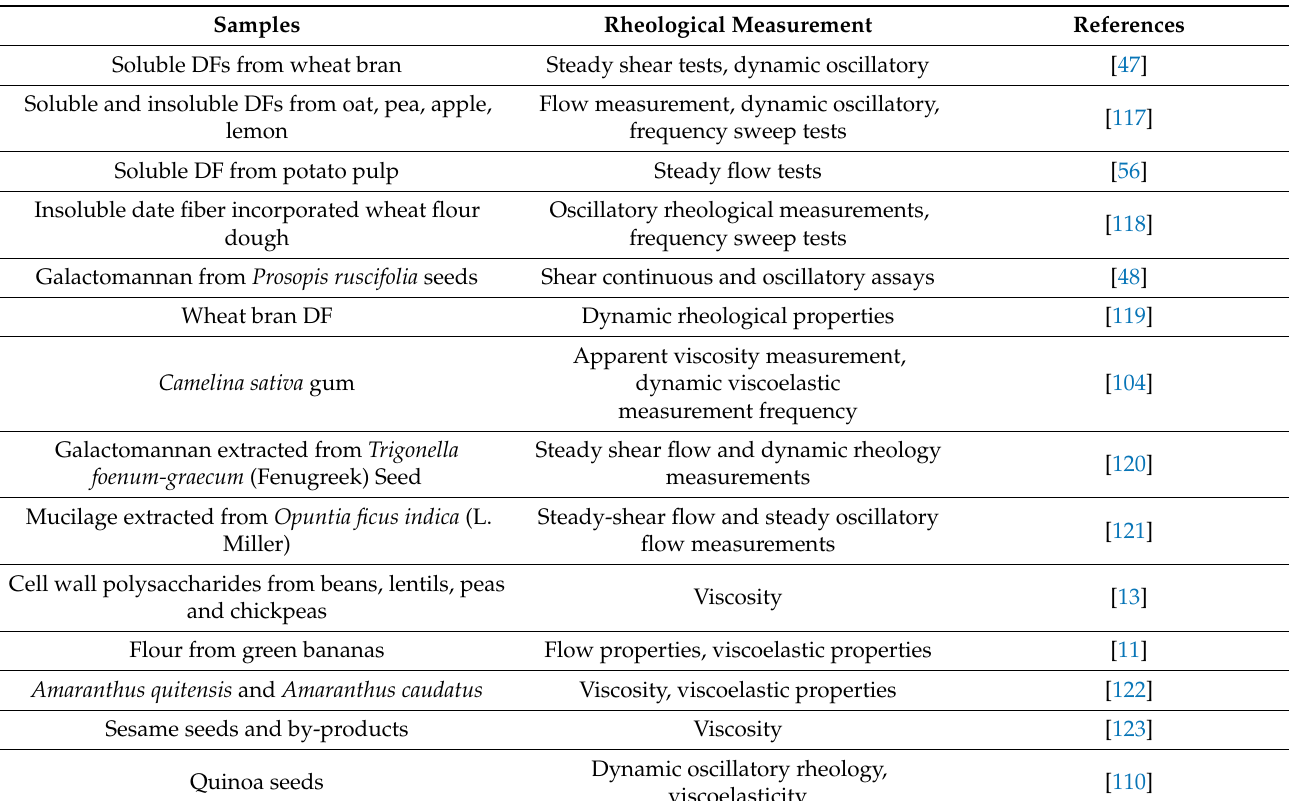
Table 3. Rheological characterization of